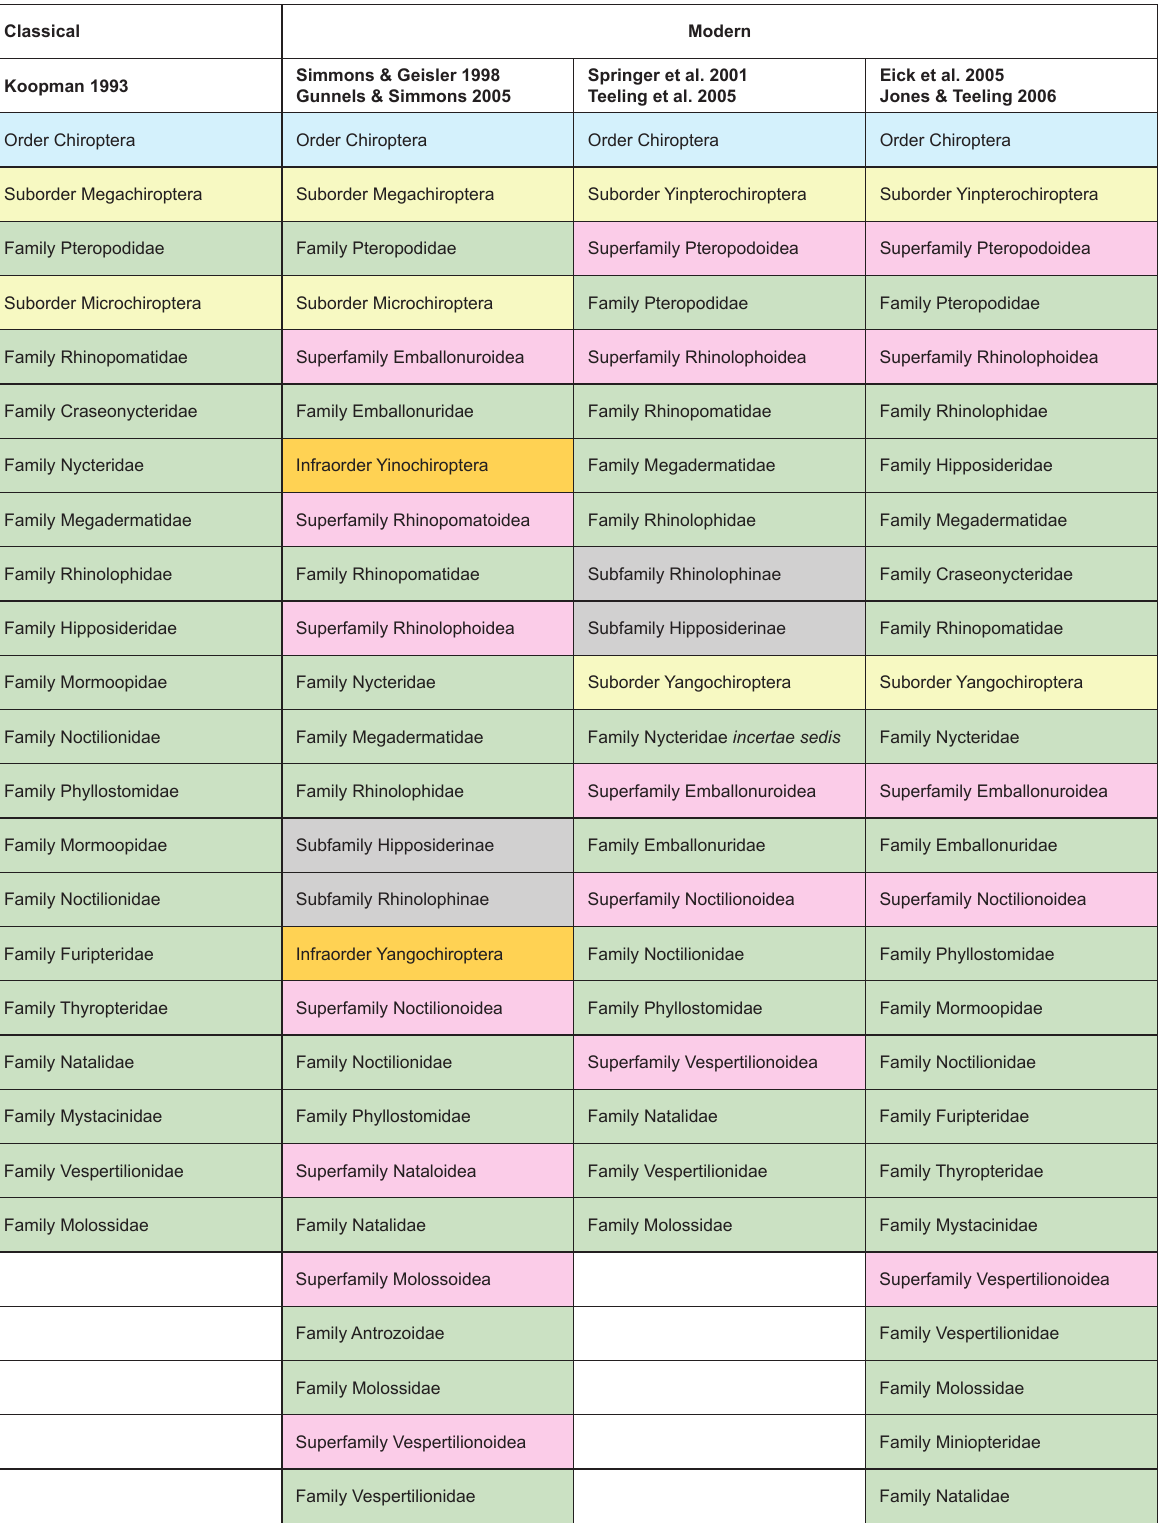
Table 1. Classical and modern classification of